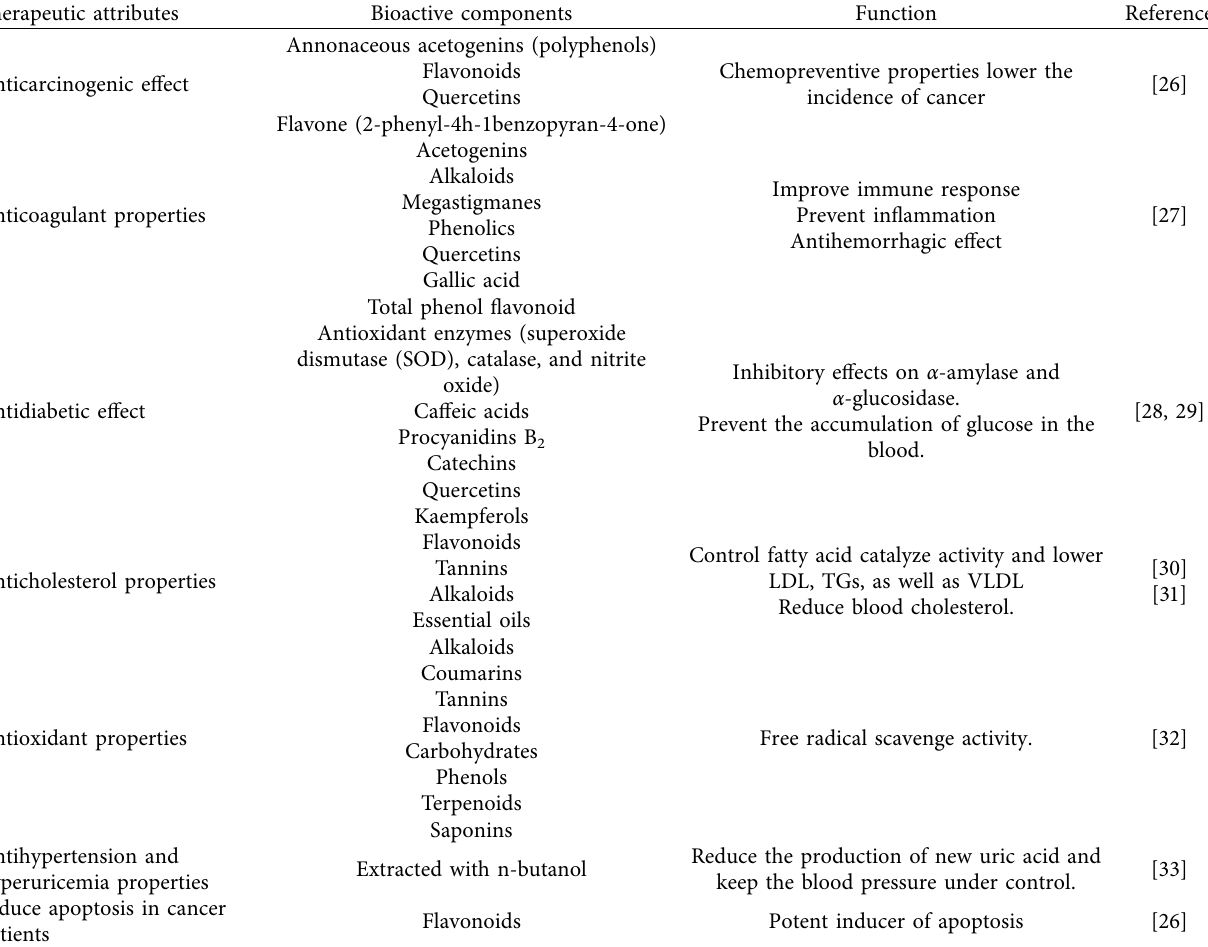
Table 2: Bioactive components along with their therapeutic